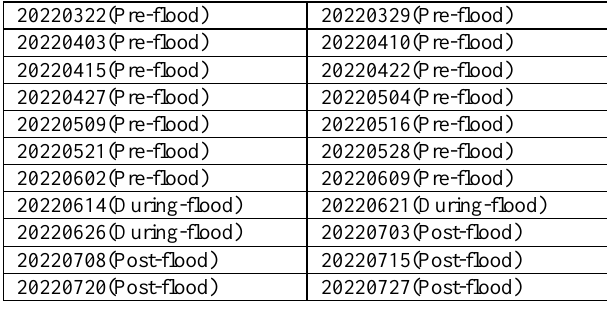
Table 1.Sentinel-1 data used for 2022 Pearl River basin flood mapping